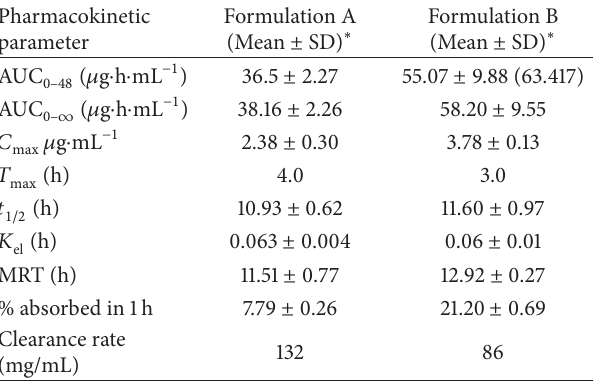
Figure 7: Mean plasma concentration-time profiles for F1 and F17 formulations after oral administration of a single dose of 20 mg/kg. Each data point is the mean ± SD from six experiments ( 𝑛 = 6 ).